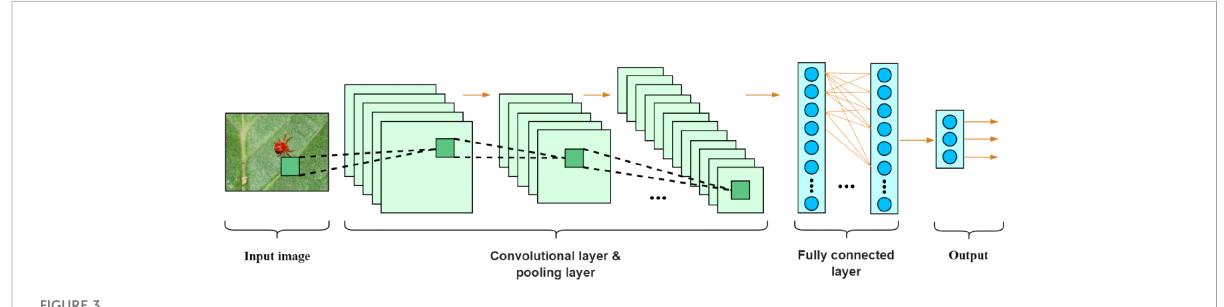
FIGURE 3 The structure of a common convolutional neural